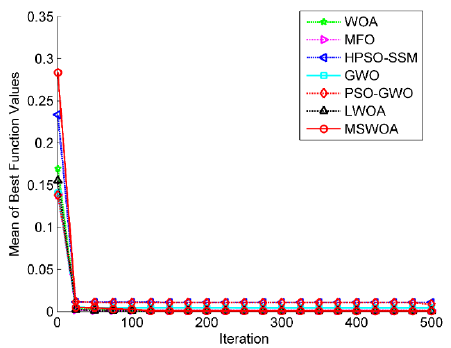
Figure 11. Optimization results for F15 (Dim = 4).